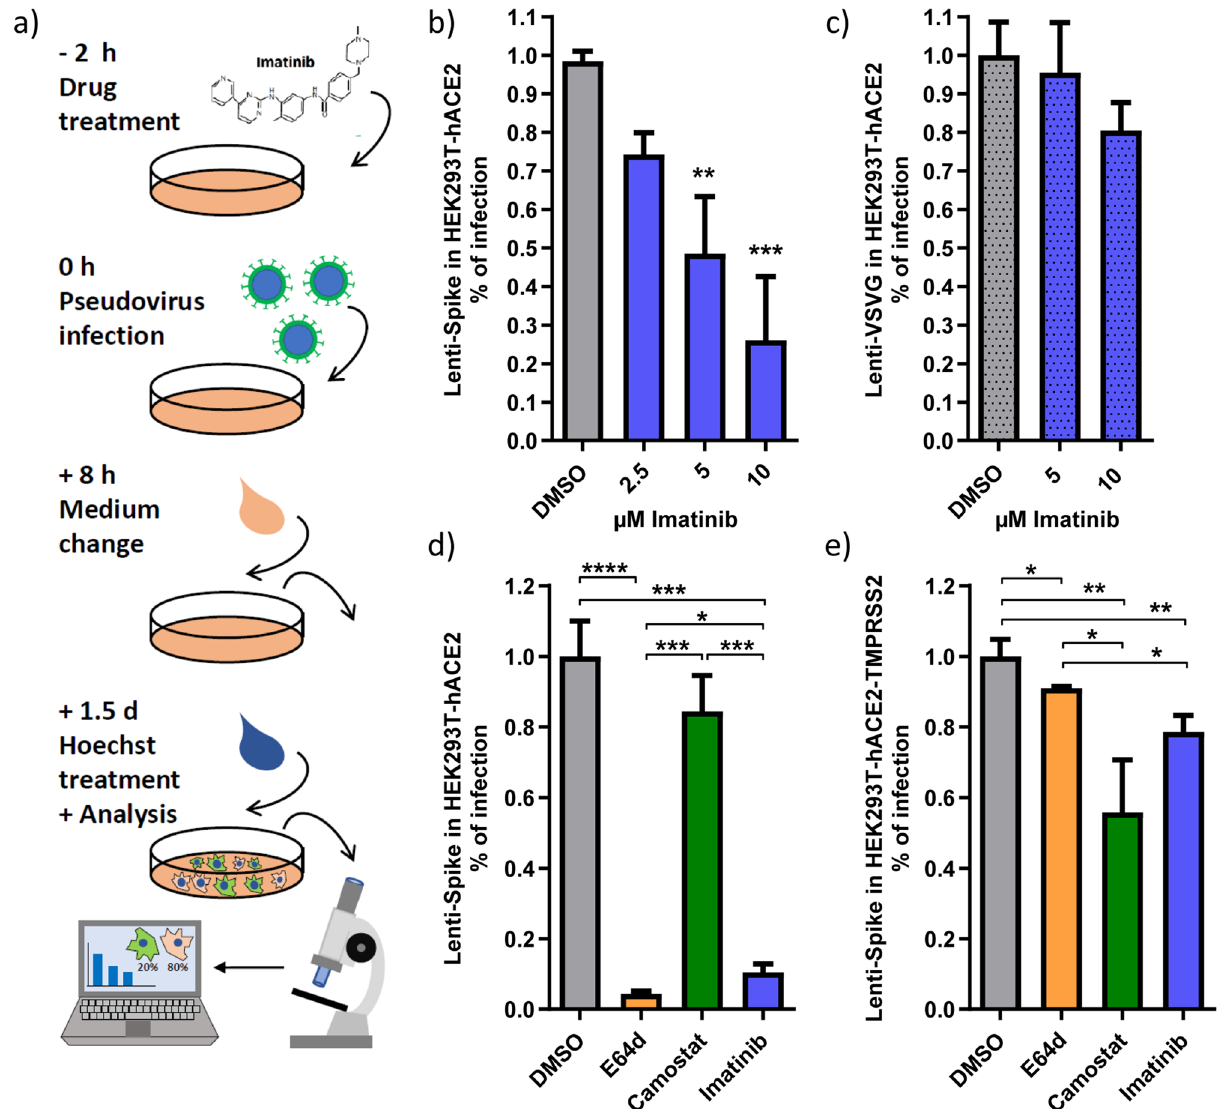
Figure 2. Imatinib specifically inhibited lenti-Spike infection in both TMPRSS2-negative and -positive cells. ( a ) A scheme of lenti-Spike experiments. HEK293T-hACE2 cells were treated with the respective drugs and 2 h later were infected on-top with lenti-Spike. Medium was replaced after 8 h with fresh growth medium. After 1.5 days, Hoechst was added to stain the cell nuclei. Ratio between total number of cells (Hoechst) and infected cells was calculated based on the transduced GFP signal. ( b ) Lenti-Spike infection is inhibited by imatinib. Cells were treated with different doses of imatinib 2 h prior to lenti-Spike infection. Infection- efficiency was determined 1.5 days later. ( c ) Imatinib inhibition is lenti-Spike specific. Cells were transduced with lenti-VSVG. ( d ) Imatinib inhibited lenti-Spike infection in TMPRSS2-negative cells. HEK293T-hACE2 were treated with each 25 µM E64d, 50 µM camostat or 10 µM imatinib, and infected with lenti-Spike 2 h later. ( e ) Imatinib reduced lenti-Spike infection in TMPRSS2-positive cells. HEK293T-hACE2 were transfected with pEFIRES-TMPRSS2 plasmid and puromycin was added a day later to select for HEK293T-hACE2-TMPRSS2 cells. Cells were treated the next day and infected as described. In panels ( b ) and ( c ) data were analyzed by One-Way ANOVA with Dunnett posttest. In panels ( d ) to ( e ) student-t-test was performed; * p ≤ 0.05; ** p ≤ 0.01; *** p ≤ 0.001; *** p ≤ affected by imatinib (Fig. 2c). Since no lenti-Spike replication is involved in these conditions, we concluded that imatinib acted at the level of lenti-Spike specific cell attachment or entry steps. Furthermore, HEK293T-hACE2 cells pretreated with imatinib for 2 h but washed-out shortly before lenti-Spike addition were well transduced (Fig. S2c), suggesting that imatinib is required at the time of infection. Imatinib inhibits both endocytosis and membrane fusion infection pathways. It was previously reported that the presence or absence of TMPRSS2 determines the SARS-CoV-2 entry route either via mem-